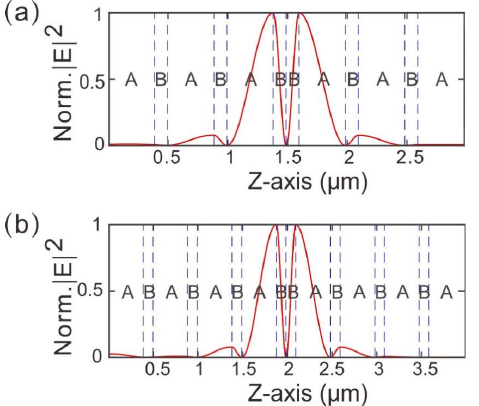
Figure 4. Electric field distribution of the defect mode. ( a ) The number of periods is N = 3. ( b ) The number of periods is N = 4.